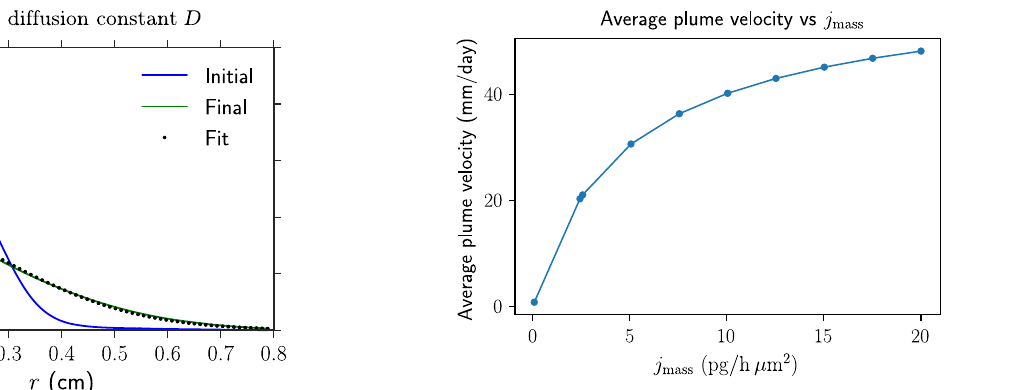
FIG. 14. Fit to the fluorescein diffusion constant D in our viscous fluid. The blue line corresponds to the measured initial radial profile, and the green line is measured the final profile. Black dotted line represents the profile predicted by Eq. (D1) with the best-fit value of D